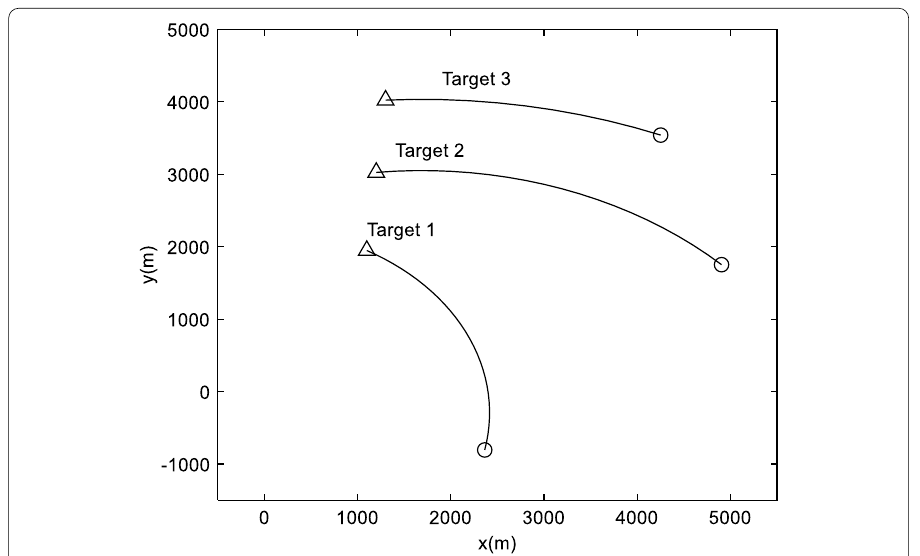
Fig. 6 Multi-target trajectories and start/stop positions are shown with with ◦ /